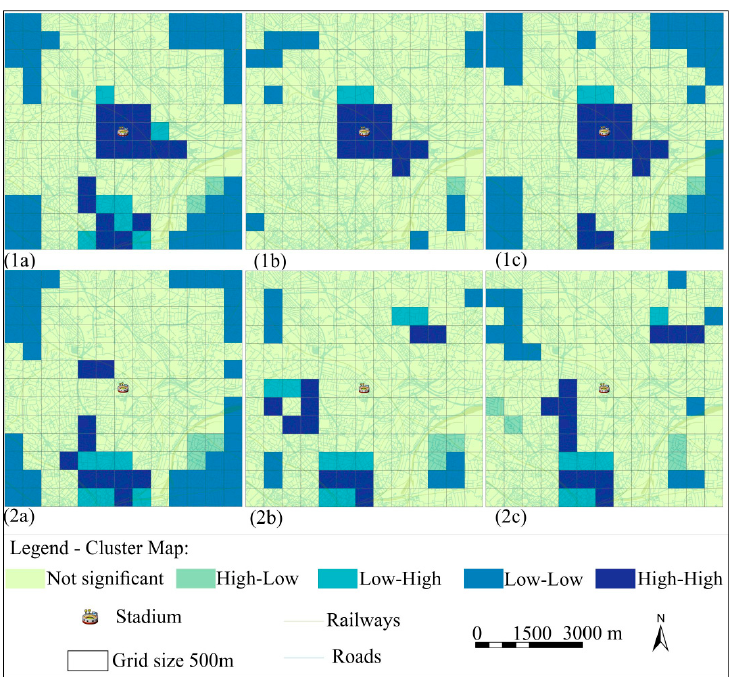
Figure 9. Bivariate LISA clusters between crime density and ( a ) tweets density, ( b ) violent tweets density, and ( c ) football topic tweets density; ( 1 ) match days, ( 2 ) comparison days.